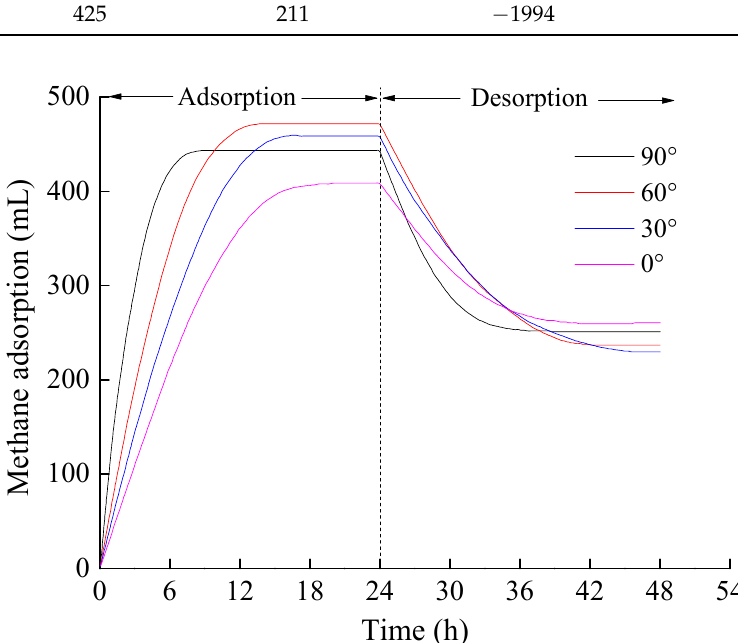
Figure 3. Gas adsorption–desorption over time.